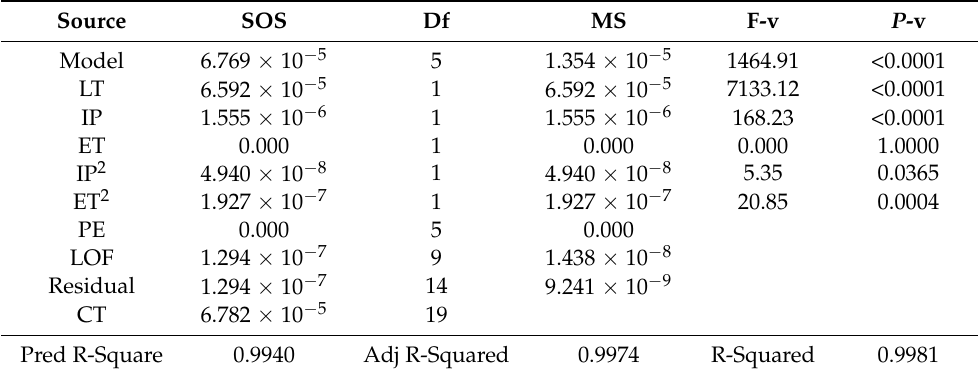
Table 8. ANOVA for production